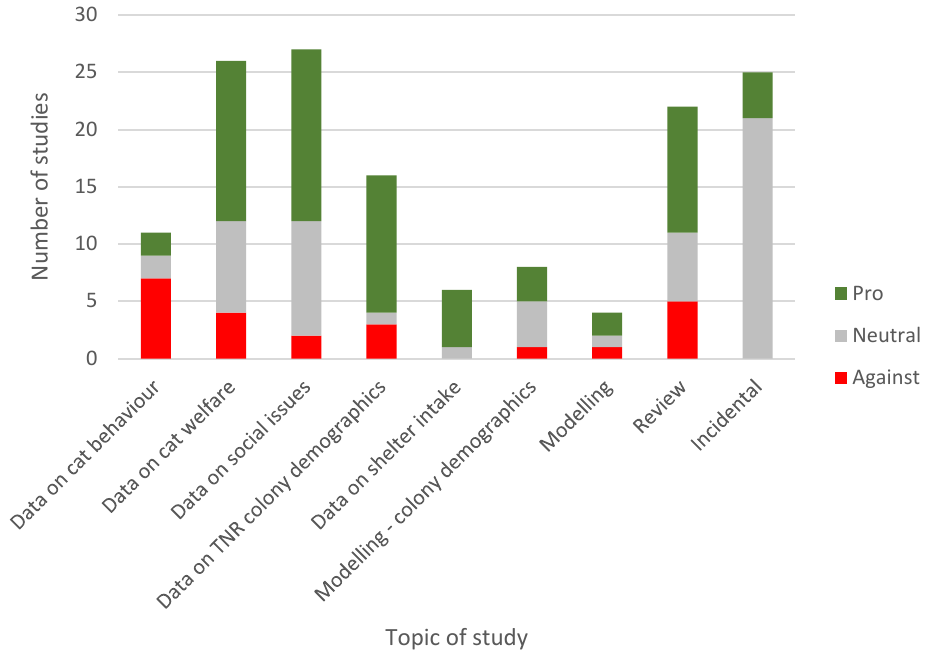
Figure 7. Number of TNR studies in each of nine topics that were positive, neutral or negative in relation to TNR.